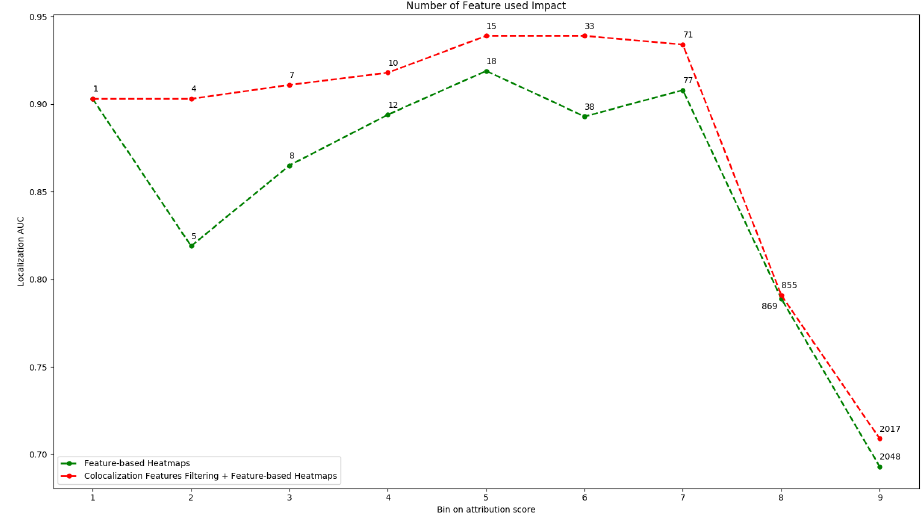
Figure 13. Colocalization filtering results for CHOWDER